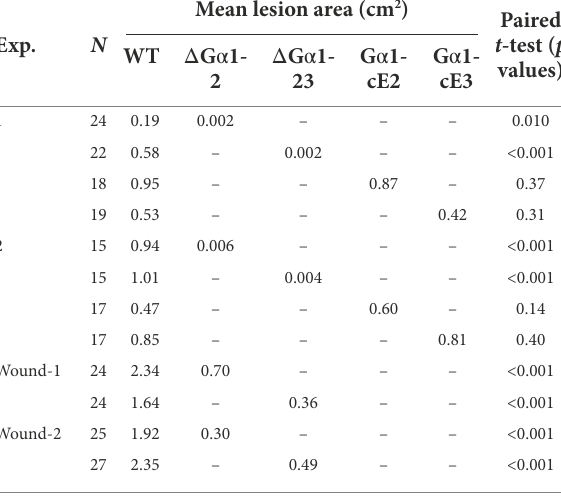
TABLE 1 Lesion sizes of mango leaves caused by Colletotrichum asianum strains TYC-2 (WT), CaG 𝛼 1 mutants ( ∆ G 𝛼 1-2, ∆ G 𝛼 1-23) and gene complementation strains (G 𝛼 1-cE2, G 𝛼 1-cE3) at 4 days postinoculation.